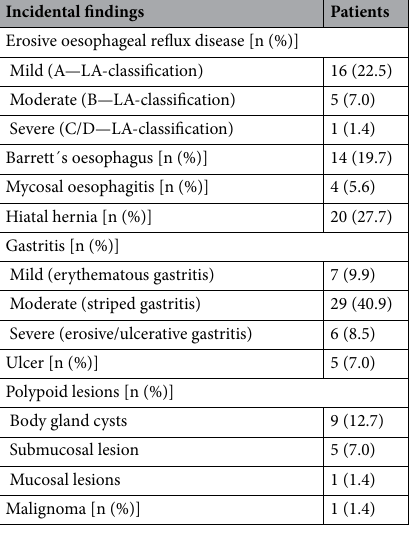
Table 1. Incidental findings of the MADE-PVI cohort prior to PVI. IQR, inter-quartile-range; n, number; PVI, pulmonary vein